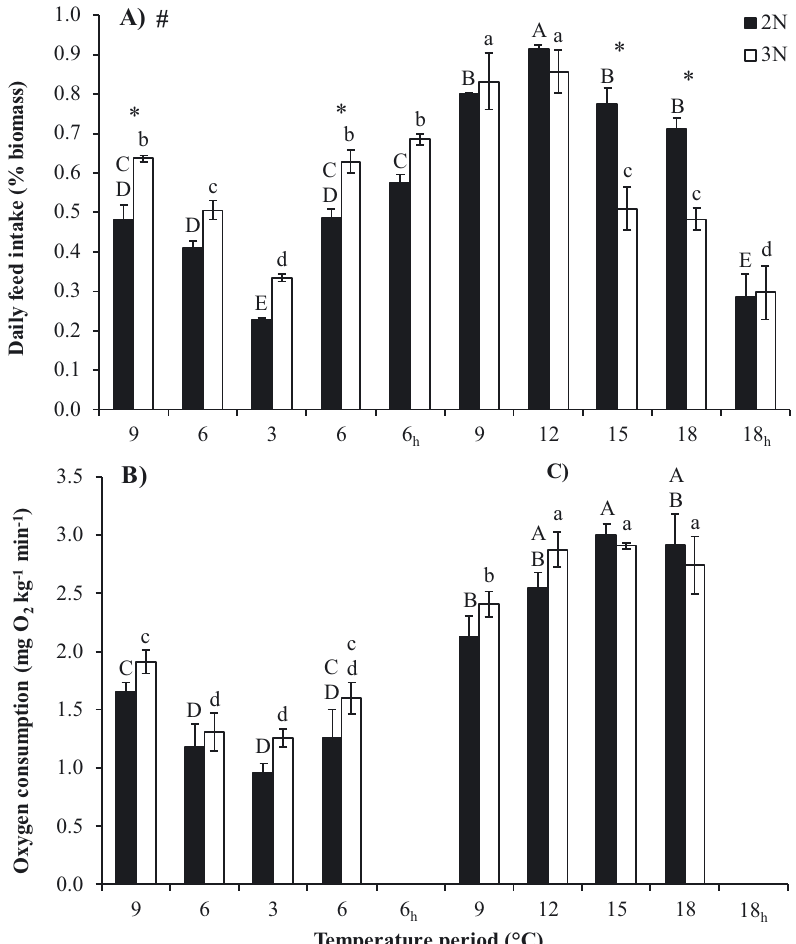
Fig. 2. Mean ± SE (A) daily feed intake and (B) oxygen consumption in tripli- cate groups of large diploid and triploid Atlantic salmon Salmo salar in sea - water. The oxygen consumption was not measured during hypoxic periods (h). Different uppercase (lowercase) letters indicate significant differences be - tween temperature periods in diploids (triploids). *Significant difference be - tween ploidies at the specific sampling point (Student-Newman-Keuls, p < 0.05); #: significant interaction between temperature period and ploidies (factorial ANOVA, p <